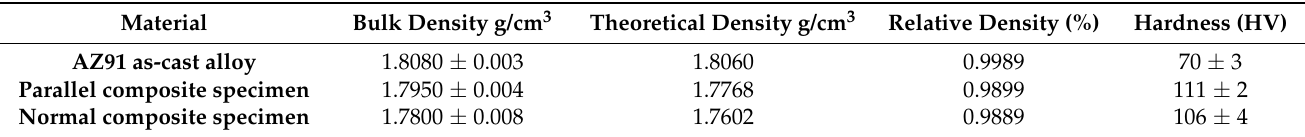
Table 3. Measured, theoretical, and relative density and hardness of the casted materials; the AZ91 matrix and the AZ91/23 vol.% carbon fiber composite